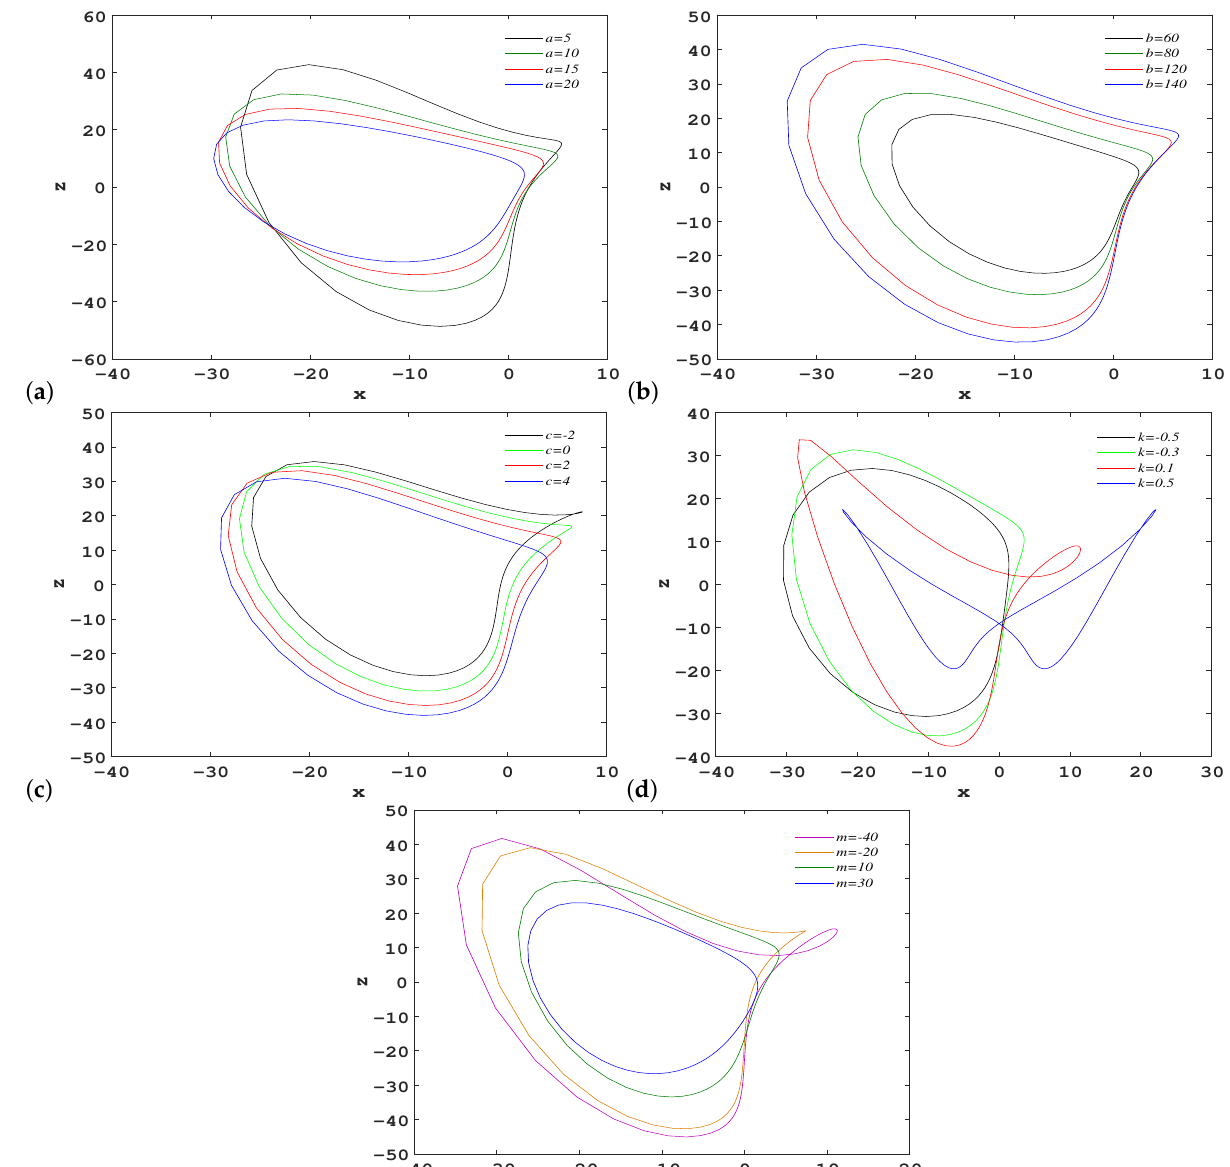
Figure 18. Homotopy evolution of cycle 2 with respect to different parameters: ( a ) four a values; ( b ) b values; ( c ) c values; ( d ) k values; ( e ) m